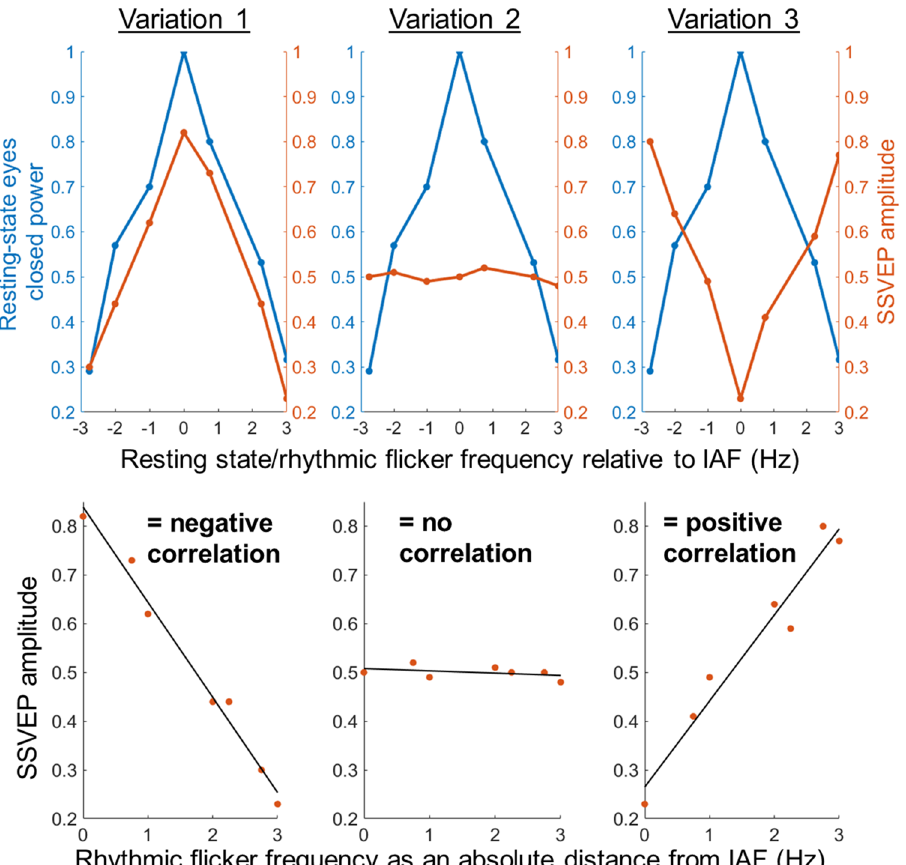
Figure 1. Hypothesis: variability of SSVEP amplitude relative to individual alpha frequency (IAF) at the source-level. Schematic illustration based on conceptual data of the hypothesised variability in SSVEP amplitude during rhythmic flicker stimulation relative to the IAF. First row, three possible variations in SSVEP amplitude profiles to rhythmic flicker relative to IAF are shown. All three oscillators show a peak in power at the IAF during resting state eyes closed (shown in blue) but heterogeneity in SSVEP amplitude to rhythmic flicker relative to IAF (shown in orange). Column 1, Variation 1 shows a maximal SSVEP amplitude at the IAF that decreases with stimulation frequencies further from the IAF, which leads to a negative correlation coefficient between the rhythmic flicker frequency as an absolute distance from IAF and the SSVEP amplitude. Column 2, Variation 2 shows no change in SSVEP amplitude as a function of the rhythmic flicker frequency’s absolute distance from IAF, leading to a near-zero correlation coefficient between the SSVEP amplitude and the absolute distance of the rhythmic flicker frequency from IAF. Column 3, Variation 3 shows a minimal SSVEP amplitude at the IAF that increases with stimulation frequencies further from the IAF, which leads to a positive correlation coefficient between the rhythmic flicker frequency as an absolute distance from IAF and the SSVEP